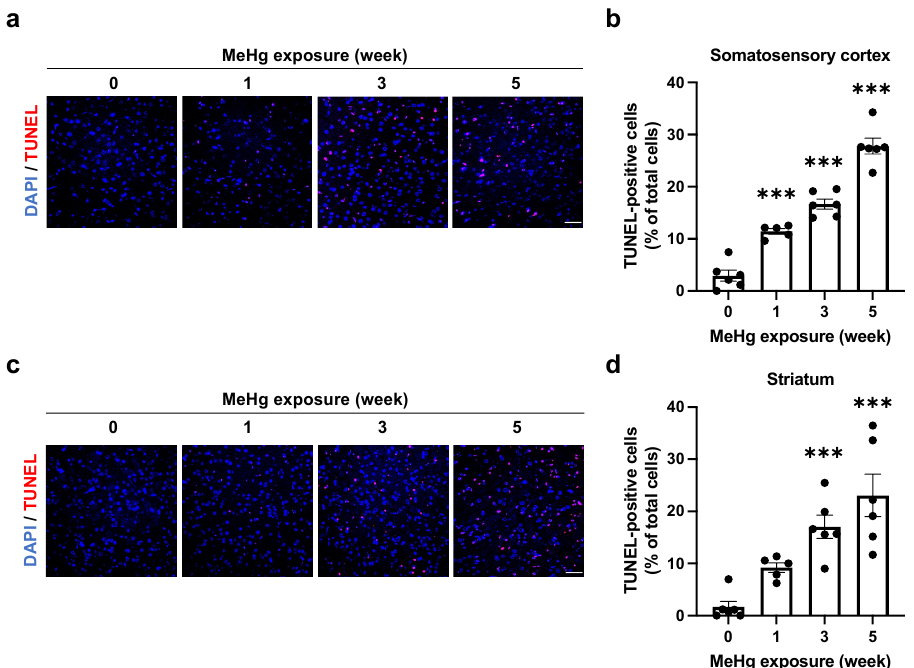
Figure 5. Induction of cell death in the mouse brain by MeHg exposure. ( a , c ) Detection of TUNEL- positive cells in the somatosensory cortex ( a ) or striatum ( c ) of ERAI-Venus mice exposed to 50 ppm MeHg for the indicated times. Each scale bar represents 50 μm. ( b , d ) Quantification of TUNEL- positive cells shown in ( a , c ), respectively. Data are expressed as the mean ± S.E.M. values (n = 5–6, *** p < 0.001: significant difference compared with control mice without MeHg exposure (0 weeks) by one-way ANOVA with Dunnett’s post hoc test).